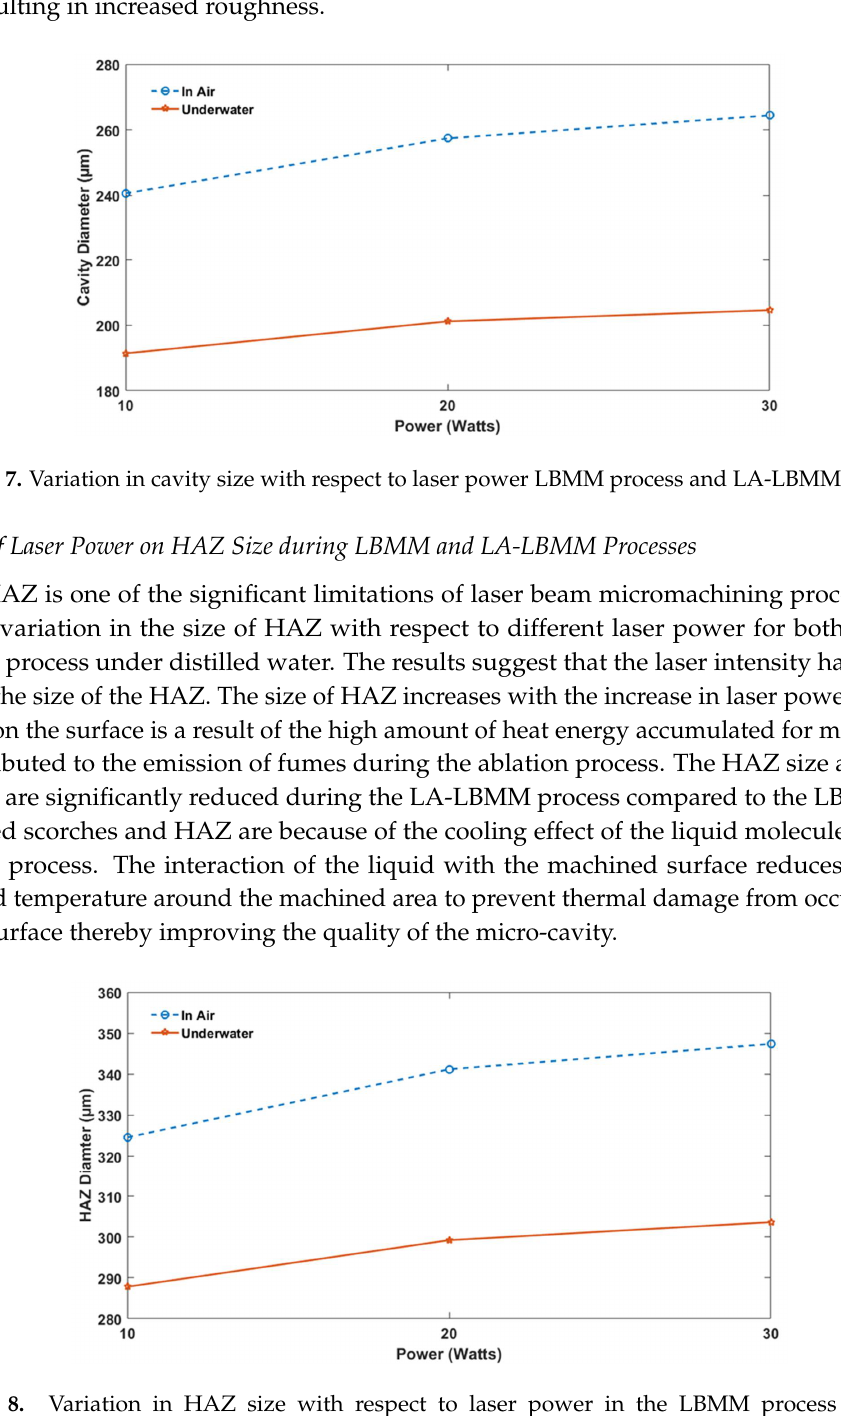
Figure 8. Variation in HAZ size with respect to laser power in the LBMM process and the LA-LBMM